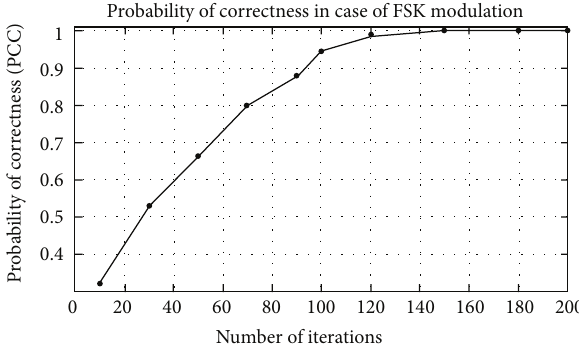
Figure 12: Probability of correctness (PCC) versus number of iterations at SNR = 10dB for FSK16 example.